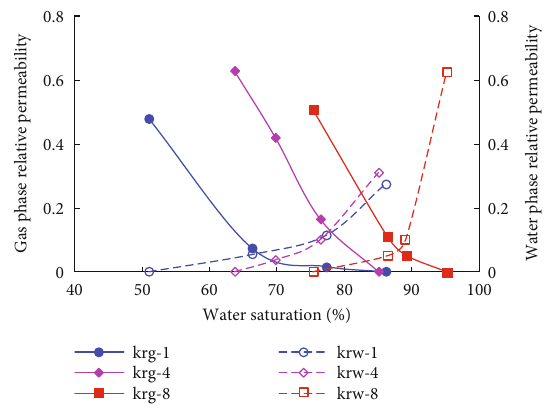
Figure 6: Gas – water permeability curves of cores with di ff erent